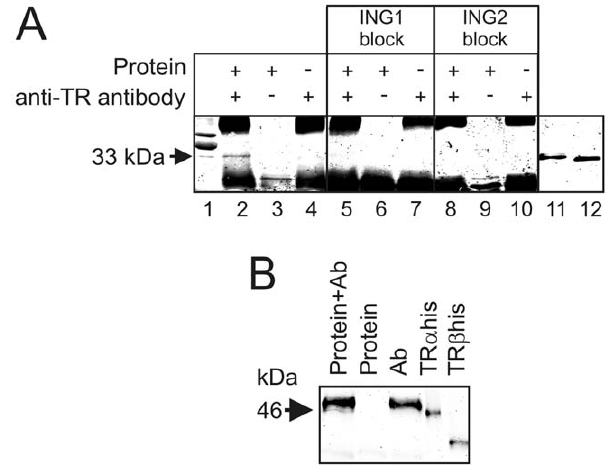
Figure 6. Evidence that ING proteins are present in TR- containing complexes. A) Endogenous p33 ING protein coimmuno- precipitates with TRs in tadpole tail homogenates. Immunoprecipita- tions with a mouse polyclonal anti-TR antibody were carried out on X. laevis total tail homogenates from metamorphic climax NF stage 60–62 tadpoles (where ING, TH, and TR levels are all high), followed by immunoblots with a mouse monoclonal anti-ING antibody. A weak, but highly reproducible, specific 33 kDa band (indicated by an arrow) was detected (lane 2) when Sepharose beads were coincubated with anti-TR antibody and tail homogenate (Protein) and not present when either was incubated alone with the beads (lanes 3–4). Lane 1, protein homogenate (30 m g). This band is also not visible in Western blots where the anti-ING antibody was preincubated with either purified, bacterially-expressed p33 ING1 (ING1 block; lanes 5–7) or p33 ING2 (ING2 block; lanes 8–10). Lanes 11 and 12 are bacterially-expressed His-tagged Xenopus p33 ING1 and p33 ING2 proteins, respectively. Neither of the two slower migrating ING isoforms in lane 1 (see [49]) was immunoprecip- itated. The strong upper and lower bands observed in lanes 2-10 are light and heavy chain immunoglobulins. B) Immunoblots of the same samples as above using another anti-TR antibody to demonstrate that TRs are immunoprecipitated. The 9B2 anti-TR antibody identified a band at , 46 kDa that comigrates with bacterially-expressed frog TR a - His protein. The results shown represent one of three experiments with similar